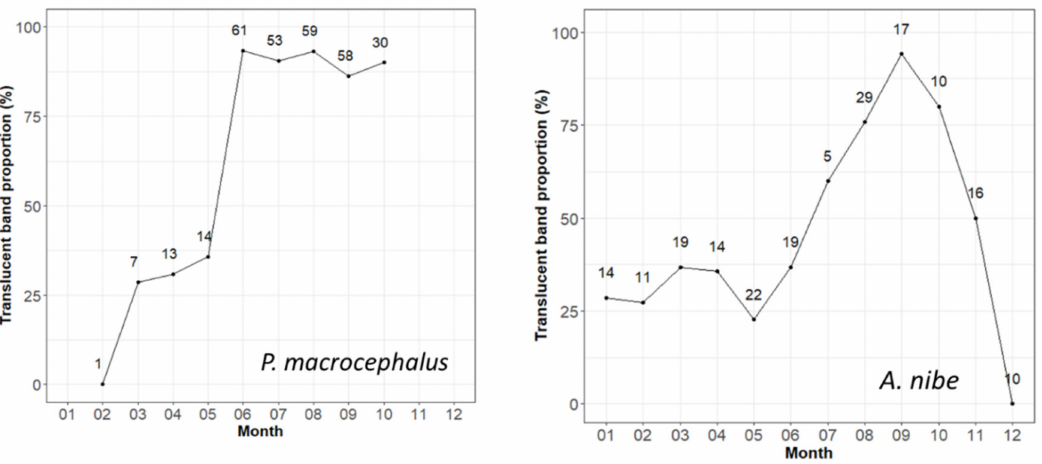
Figure 5. Monthly percent occurrence of the translucent band at the edge of samples from P. macro- cephalus and A. nibe . Numbers indicate the sample